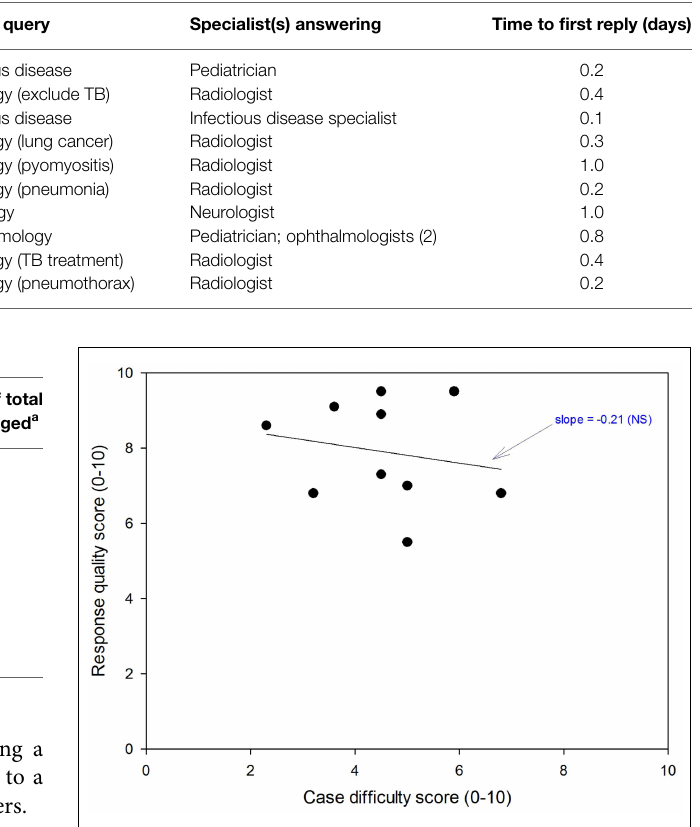
FIGURE 1 | Relation between the difficulty of the telemedicine cases and the quality of the subsequent teleconsultation .